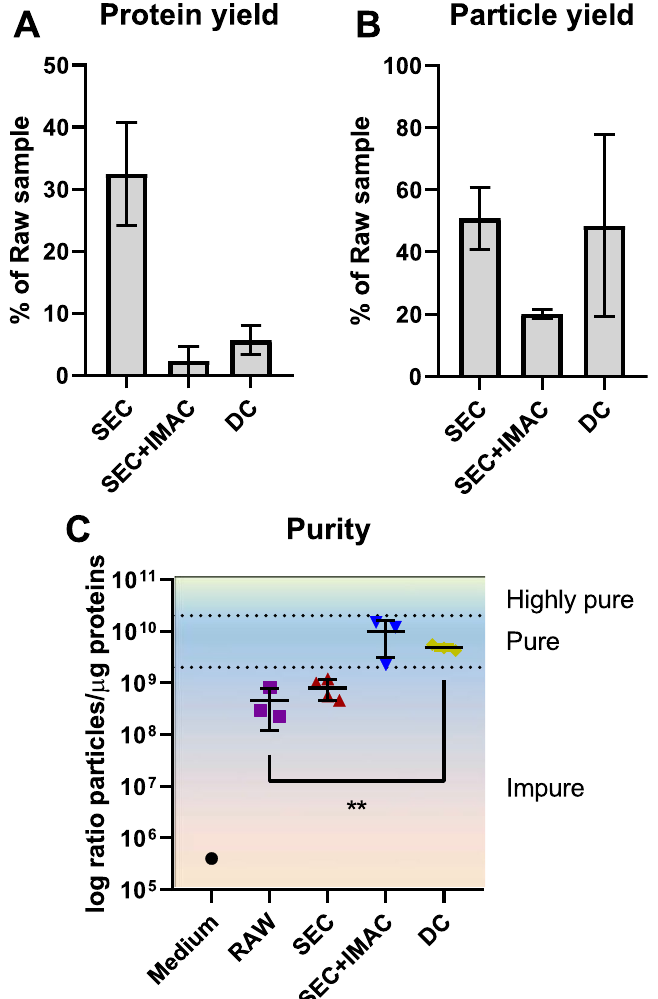
Figure 2. Yield and purity of EV preparation. Supernatant samples were purified either by the two-step FPLC method or by the conventional DC protocol. ( A ) Protein recovery from the intermediate SEC step (n = 3) and the final SEC + IMAC (n = 3) and DC (n = 4) products was estimated by a BCA assay and expressed as percentage of the protein content of the starting raw sample. ( B ) Particle recovery from the intermediate SEC step (n = 2) and the final SEC + IMAC (n = 2) and DC (n = 3) products was estimated with NTA and expressed as percentage of the particle content of the raw sample. ( C ) We considered the ratio number of particles/µg protein as a measure of purity of the EV preparation. Both the SEC + IMAC (n = 3) and the DC (n = 3) product fall in the range of what are considered pure EV preparations. Each symbol in the graph represents one sample. Data is represented as mean ± s.d. **= p <